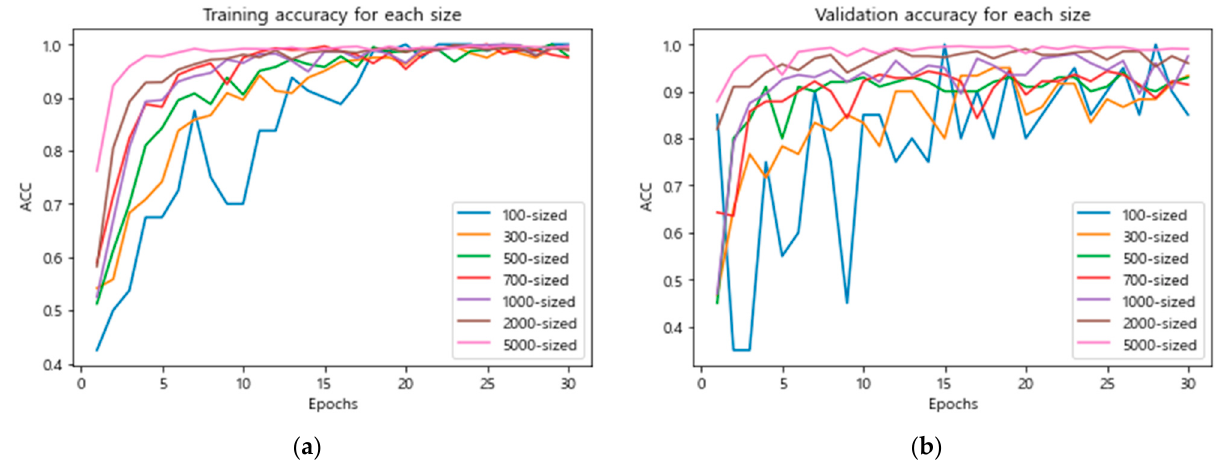
Figure 5. ( a ) Accuracy changes in training set for each size; ( b ) accuracy change in validation set for each size.